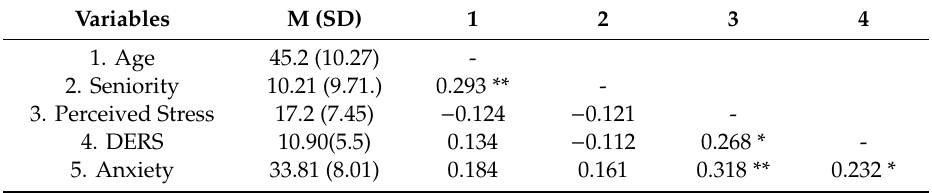
Table 5. Zero-order correlations between the variables of the study in the control group (POST).